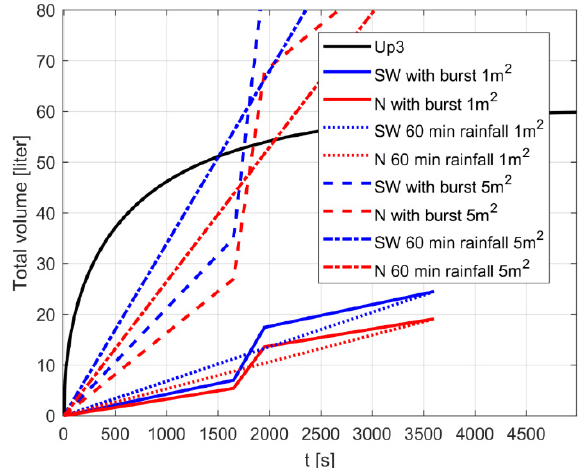
Figure 12. Comparison between the cumulative rainfall volume and Up-flow SPB (Up3) storage filling (black solid line) for various inflow scenarios: two climatic regions (N and SW), two shapes of rainfall hyetographs (block rainfalls without and with a high intensity burst; blue and red lines, respectively), and two runoff contributing areas (1 and 5 m 2 , respectively). The figure also demonstrates the storage capacity of the SPB.